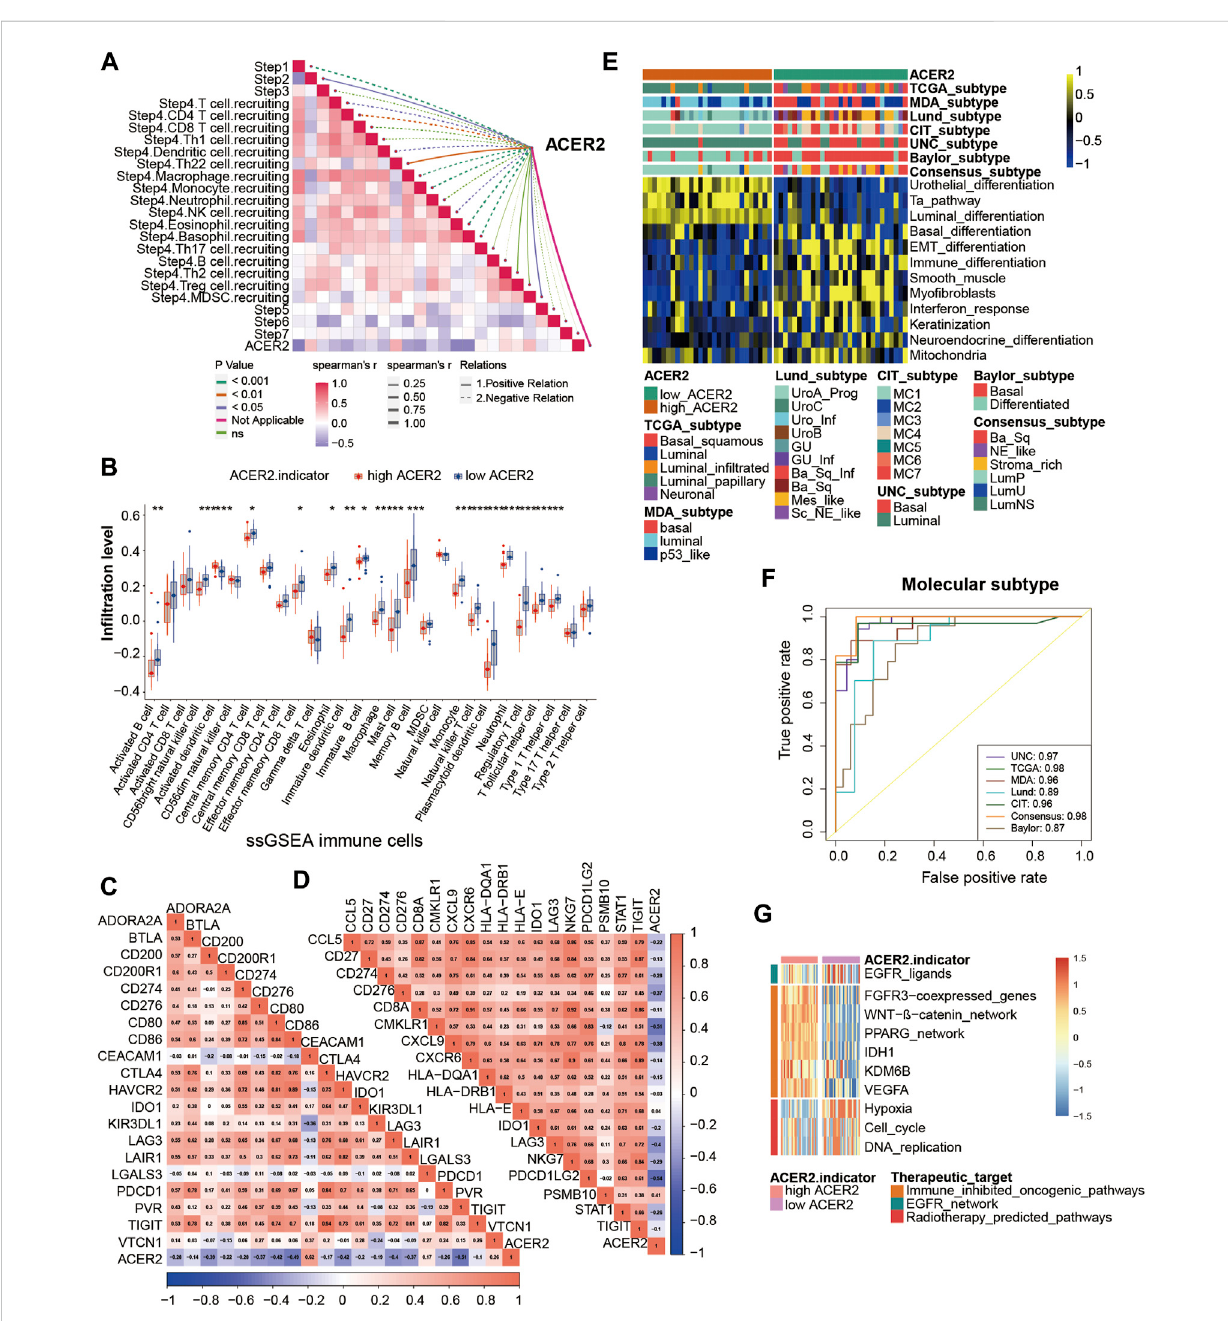
FIGURE 5 Validation of the ACER2 prediction for molecular subtypes and the response to several therapies in the Xiangya cohort. (A) Correlations between ACER2andtheprocessoftheanti-cancerimmunitycycle. (B) CorrelationsbetweenACER2andmultiplessGSEAimmunecells. (C) Correlationsbetween ACER2 and 20 immune checkpoints. (D) Correlation between ACER2 and TIS-related effector genes. (E) Correlations between ACER2 and seven molecular subtype systems. (F) ACER2 molecular subtype prediction accuracy. (G) Correlation between ACER2 and the enrichment scores of therapeutic